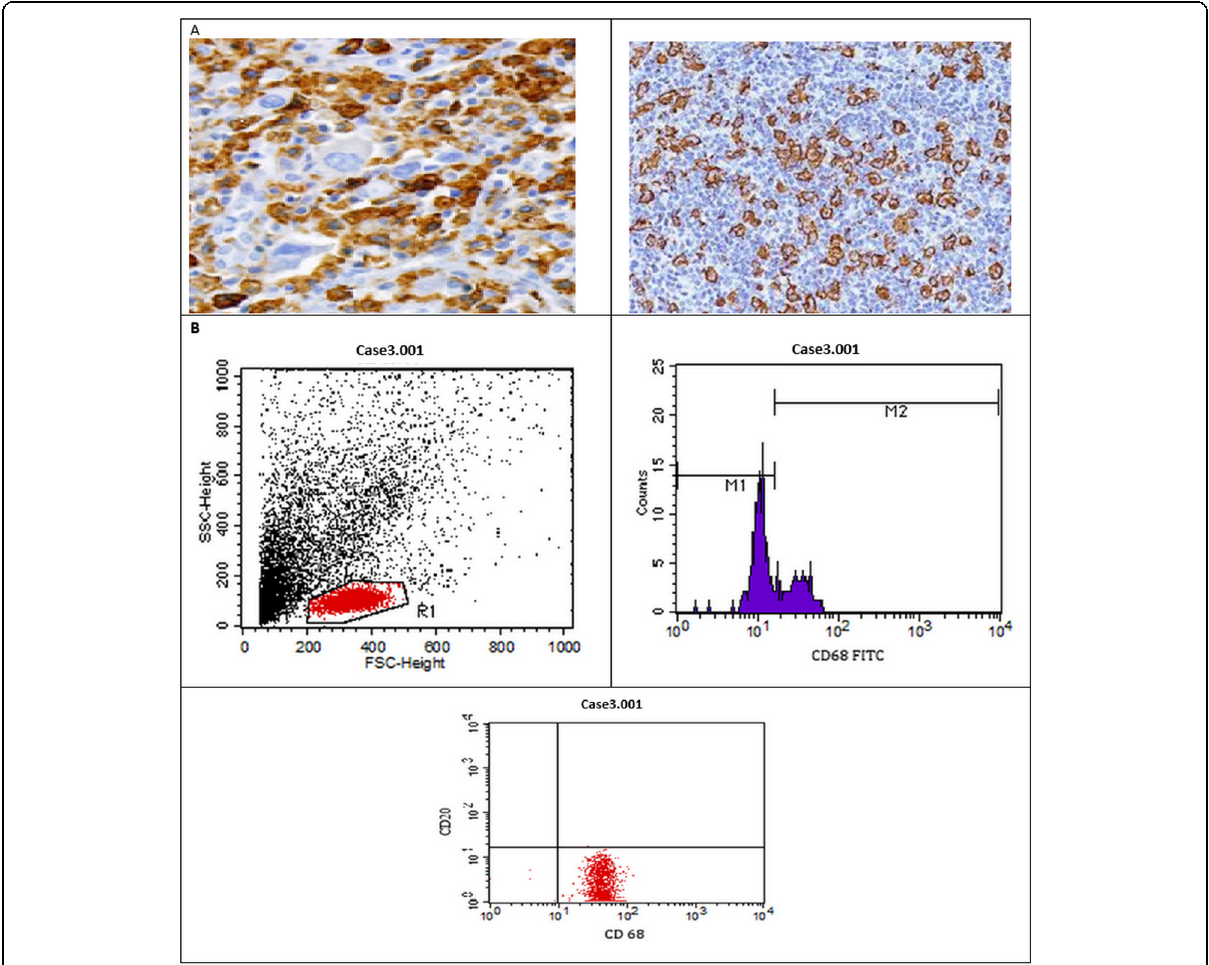
Fig. 2 a Immuno-histochemical staining of CD68 + TAM in cHL (200X), b Assessment of CD 68 and CD 20 by flow